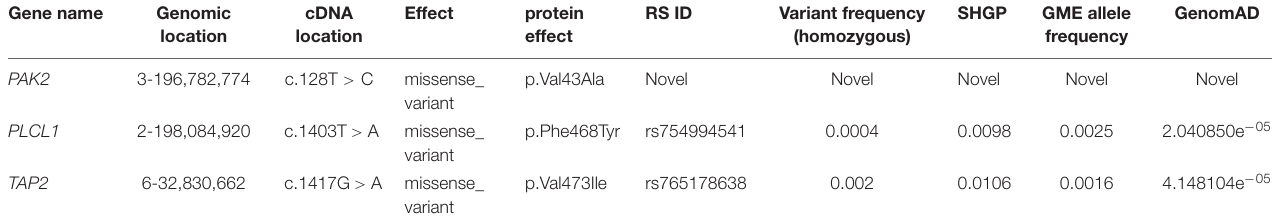
TABLE 2 | List of nucleotide variants from exome data which is found only in the affected individuals with the frequencies of the three rare variants in SHGP, GME, and genomAD.